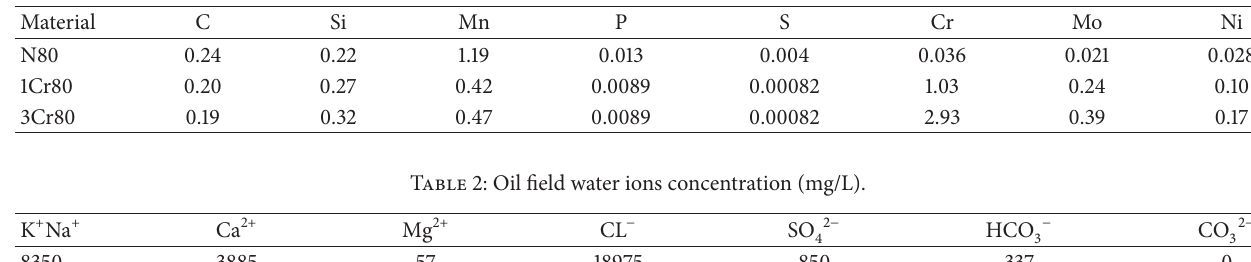
Table 1: Chemical compositions of N80, 1Cr80, and 3Cr80 (mass fraction, wt%).